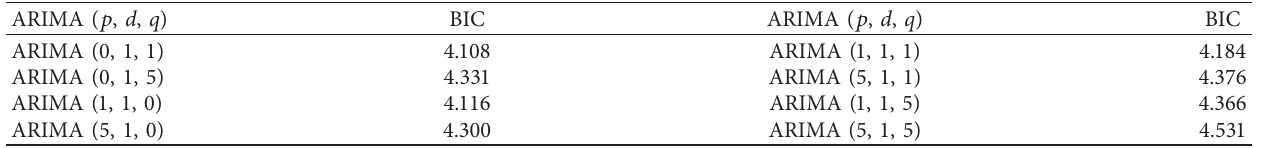
Table 6: Model parameter determination.